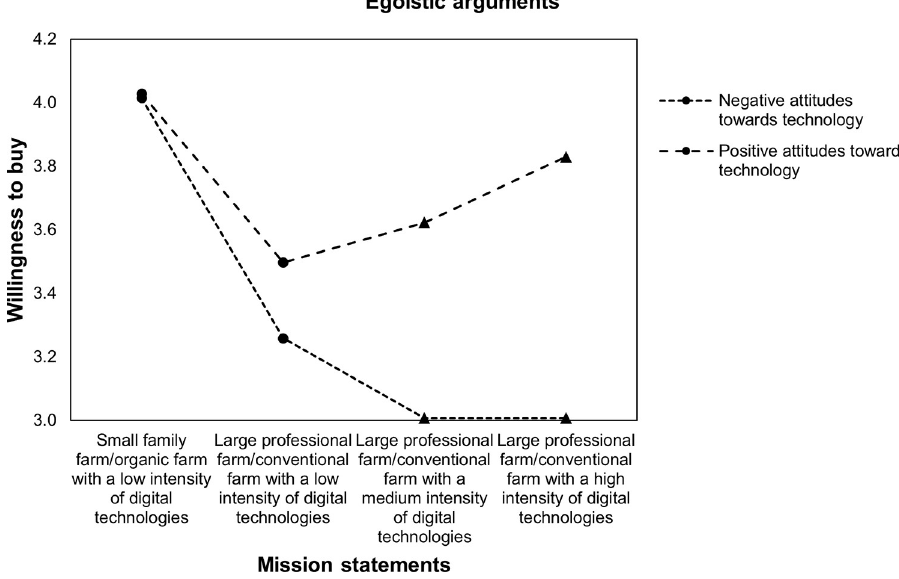
Fig 5. Profile plot of WTB food and attitudes towards technology with egoistic arguments.